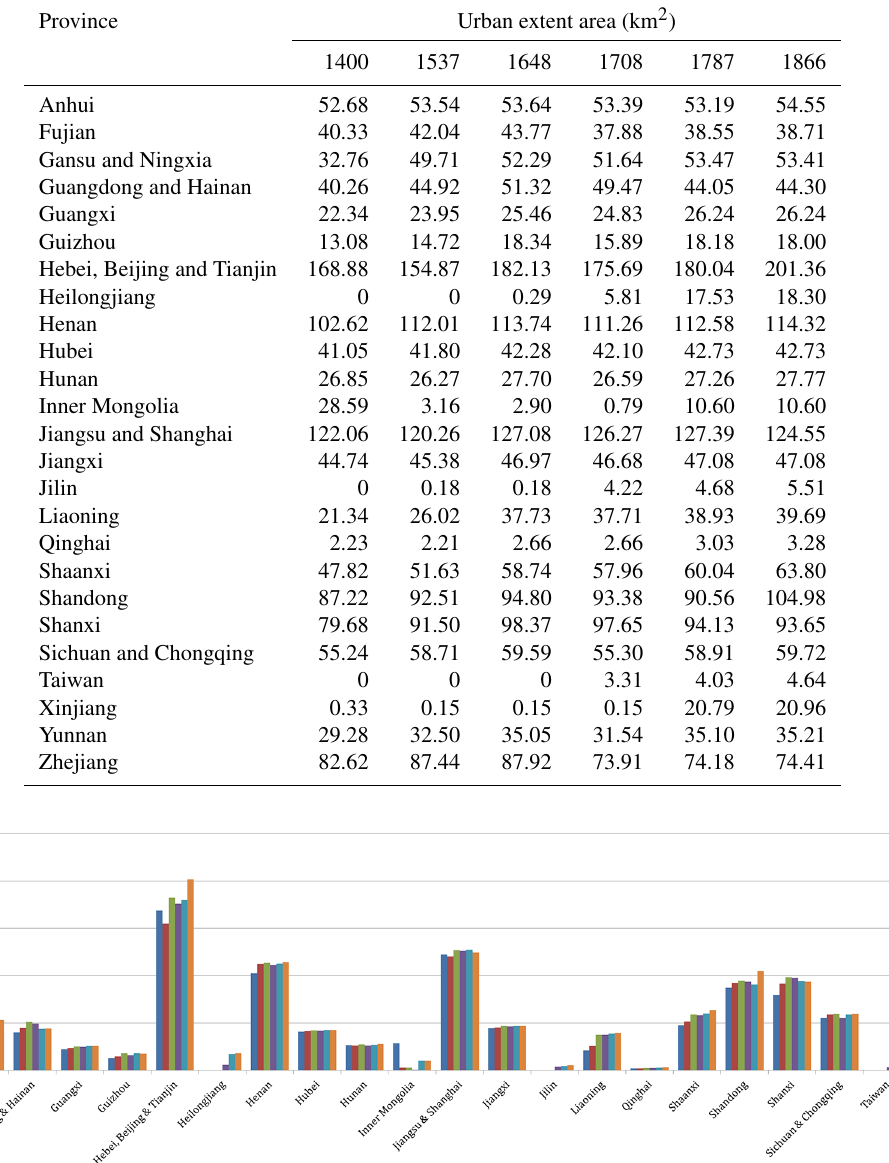
Table 1. Provincial distribution of urban extents in the 15th–19th centuries.